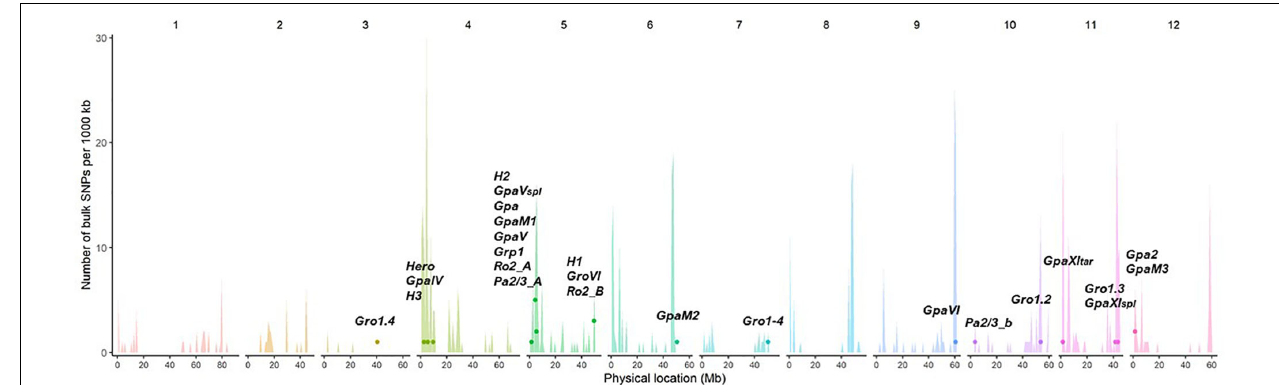
FIGURE 5 | Potato cyst nematodes (PCN) resistance loci align with known R gene clusters. The unequal distribution and position of predicted NB-LRR genes in the genome of DM is illustrated in the histogram, with spikes indicating clusters of resistance. The approximate relative location in the reference genome DM (PGSC v4.03) of known nematode resistance genes and QTLs are displayed as dots. The histogram spikes indicate numbers of predicted NB-LRR genes per 1,000 kb across the potato